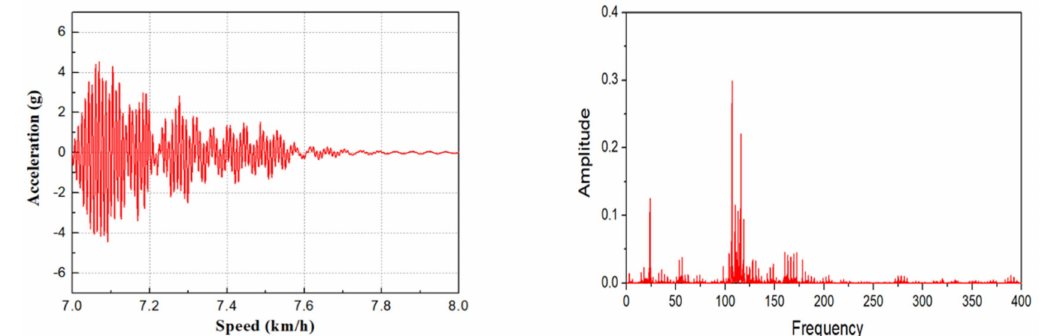
Figure 10. Natural frequency calculation results for the track girder